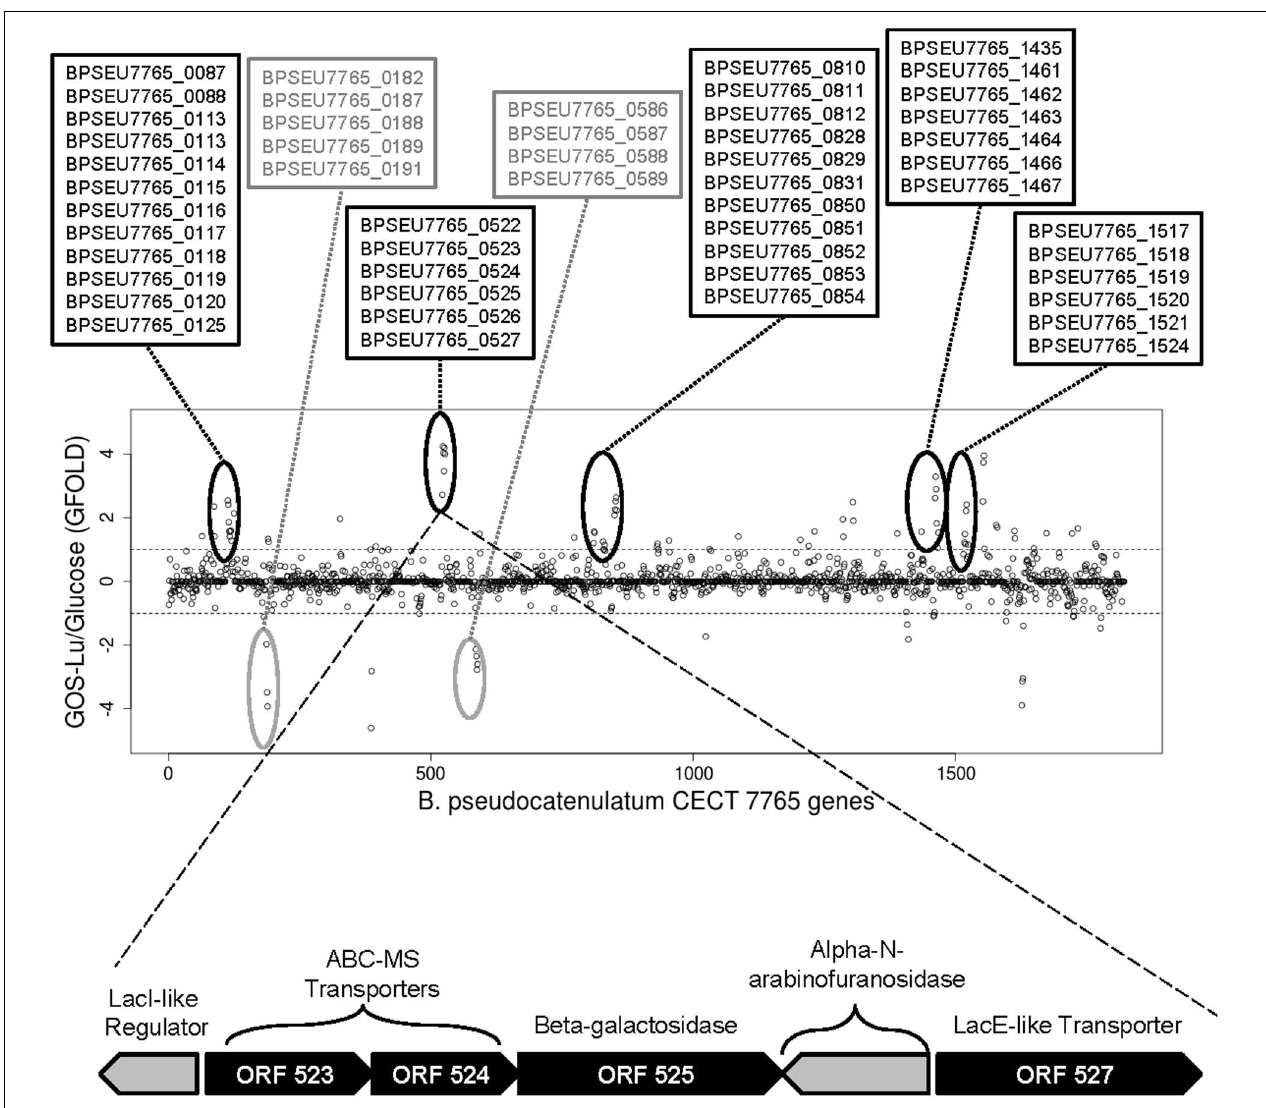
FIGURE 3 | Exploratory RNA-seq analysis throughout the B. pseudocatenulatum CECT 7765 genome. A single-replicated RNA-seq approach, using pooled samples, was used to detect genomic regions displaying up- and down-regulation trends in response to GOS-Lu. Gene expression bias based on normalized GOS-Lu/Glucose ratios obtained from GFOLD analysis (see methods) is presented across the B. pseudocatenulatum CECT 7765 genome. Inner dashed lines indicate threshold to consider a likely up- or down-regulation (GFOLD score ≤ − 1 or ≥ 1, p < 0.01). Clustered genes showing clear over-expression or down-regulation are highlighted in black or gray ovals. Tags of genes present in those regions are annotated in the text boxes at the top. The specific genetic structure of the gene cluster exhibiting the strongest expression change associated with GOS-Lu fermentation is shown below, with the respective KEGG-based functional annotation for each